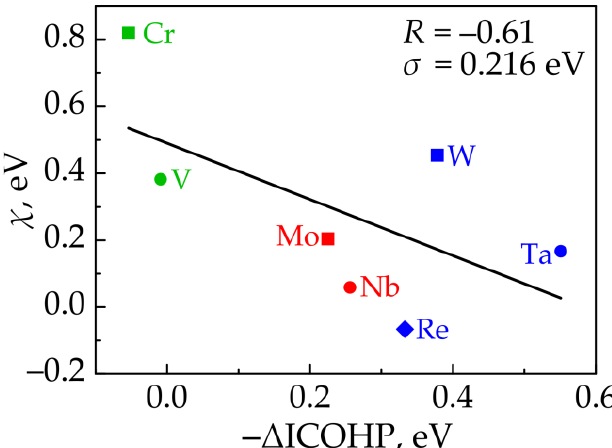
Figure 5. Correlation between chemical contribution χ to the defect formation energy and difference in ICOHP per bond between impurity–matrix and Ti–matrix bonds. The solid lines are obtained by the least-squares method.